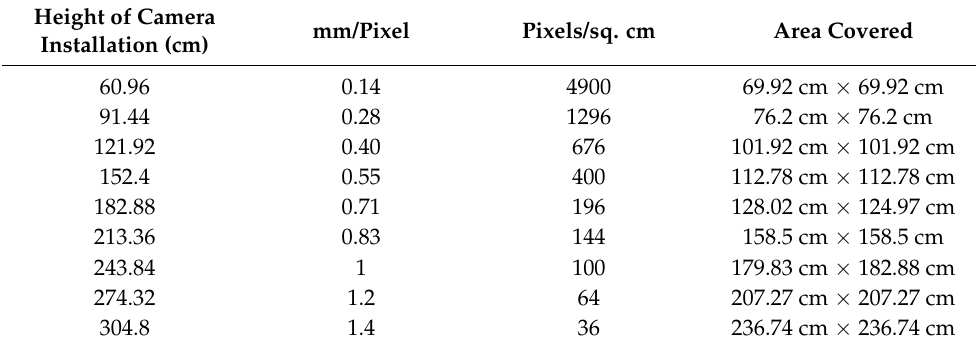
Table 2. Pixel resolution of